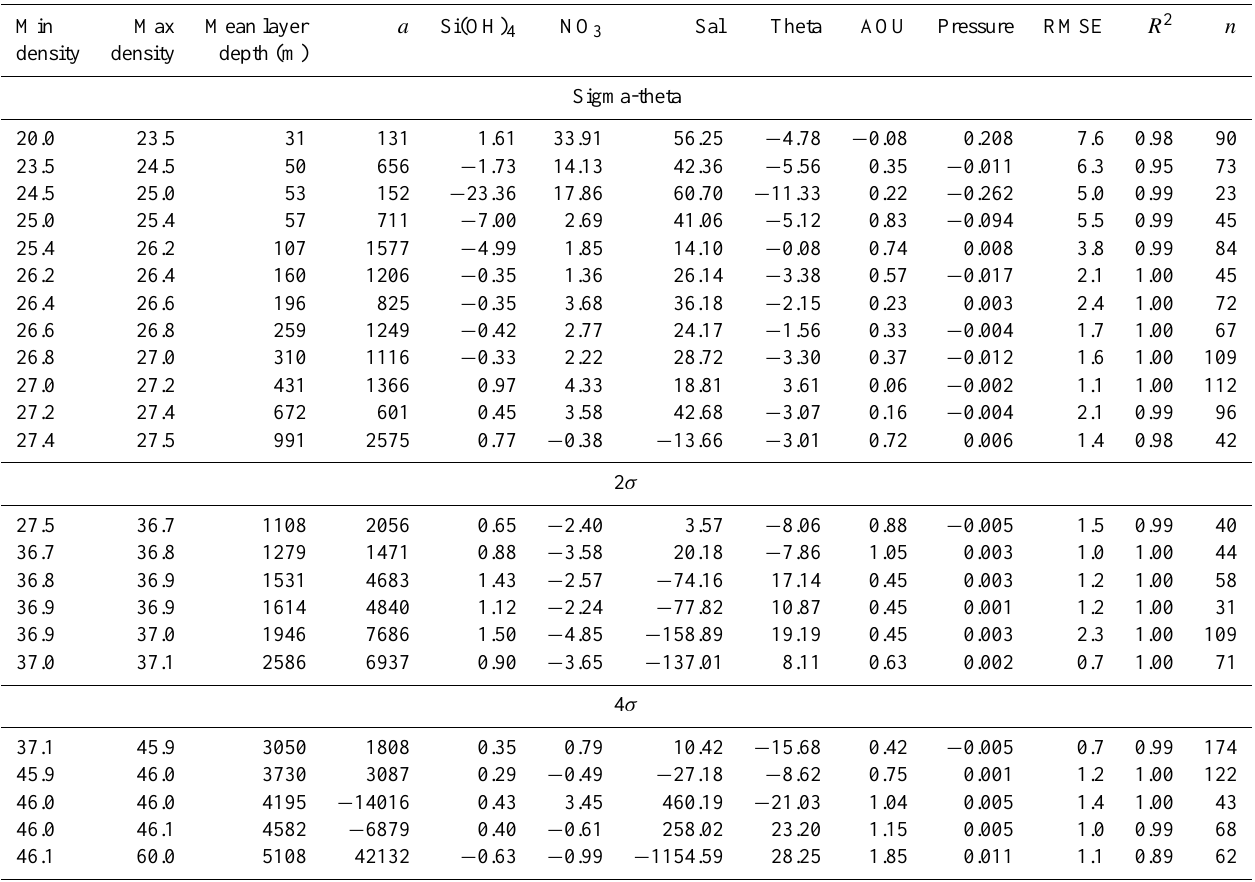
Table 1a. Calculated coefficients for the performed multi linear regressions for each density interval using the (a) GEOTRACES-NL (2010/2011) data set and (b) WOCE ’94 A17 data set. Differences between the coefficients were calculated following Eq. (2).